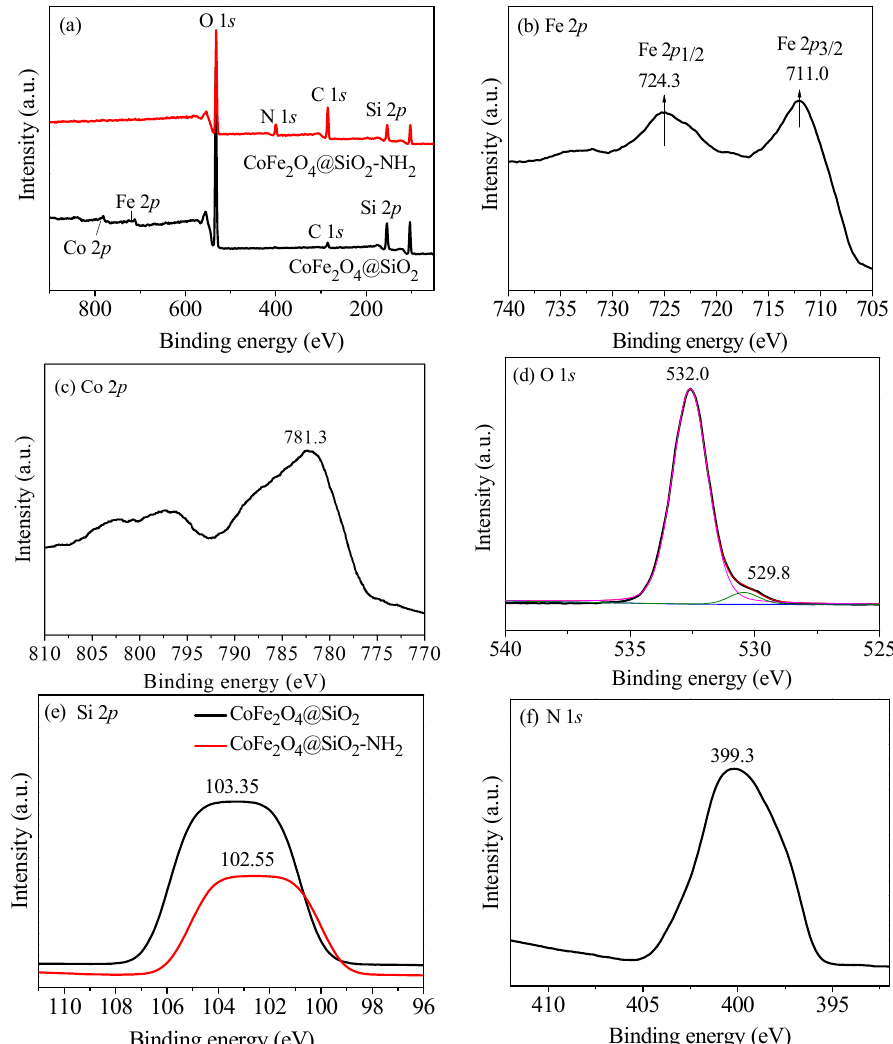
Figure 7. XPS spectra of ( a ) CoFe 2 O 4 @SiO 2 and CoFe 2 O 4 @SiO 2 –NH 2 ; ( b ) Fe 2 p ; ( c ) Co 2 p ; ( d ) O 1 s of CoFe 2 O 4 @SiO 2 –NH 2 ; ( e ) Si 2 p of CoFe 2 O 4 @SiO 2 and CoFe 2 O 4 @SiO 2 –NH 2 ; and ( f ) N 1 s of CoFe 2 O 4 @SiO 2 –NH 2 . All of the materials were virgin.